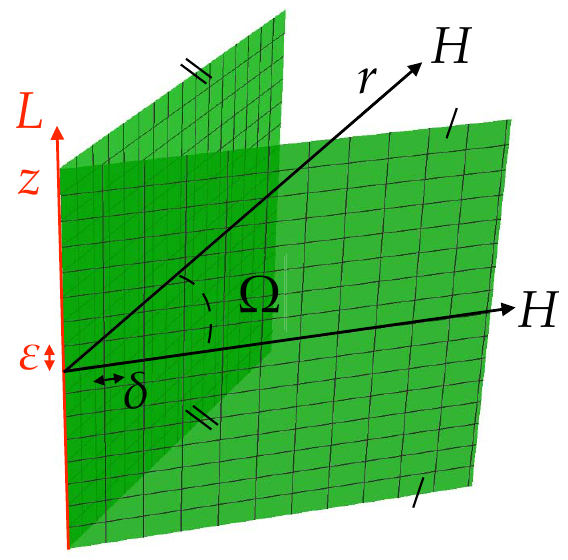
Figure 3 . We plot a wedge-shaped entangling surface of opening angle Ω and a corner region in one dimension less resulting from its dimensional reduction. While the wedge contribution to the entanglement entropy - f (Ω) H/δ gets polluted by the presence of inequivalent regulators along the radial and transverse directions — see eq. (3.20)— the dependence on the opening angle is